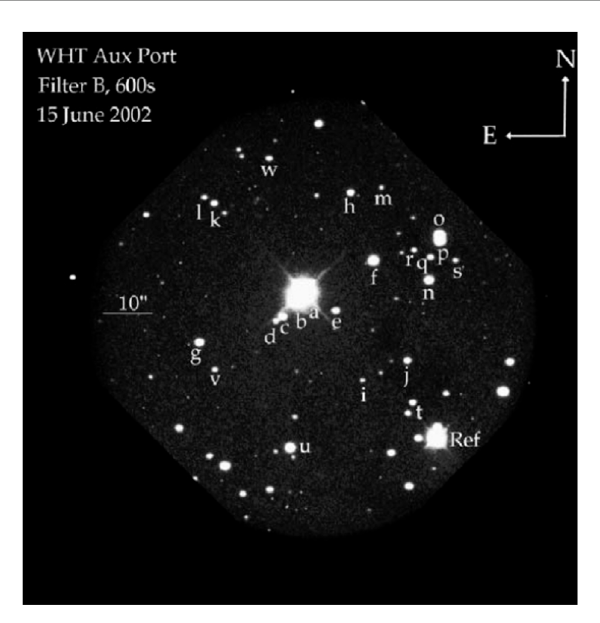
FIGURE 7 Image from the Auxiliary Port at the William Herschel Telescope of the center of the field of SN 1572. It reveals that it is far from being a crowded field. The initial search area in RL04 covers a radius of 0.65 arcmin around RA = 00 h 25 min 19.9 s, Dec. = 64 o 08 ′ 18.2” (J2000) (the Chandra geometrical centre of X–ray emission). From the author’s personal archive.